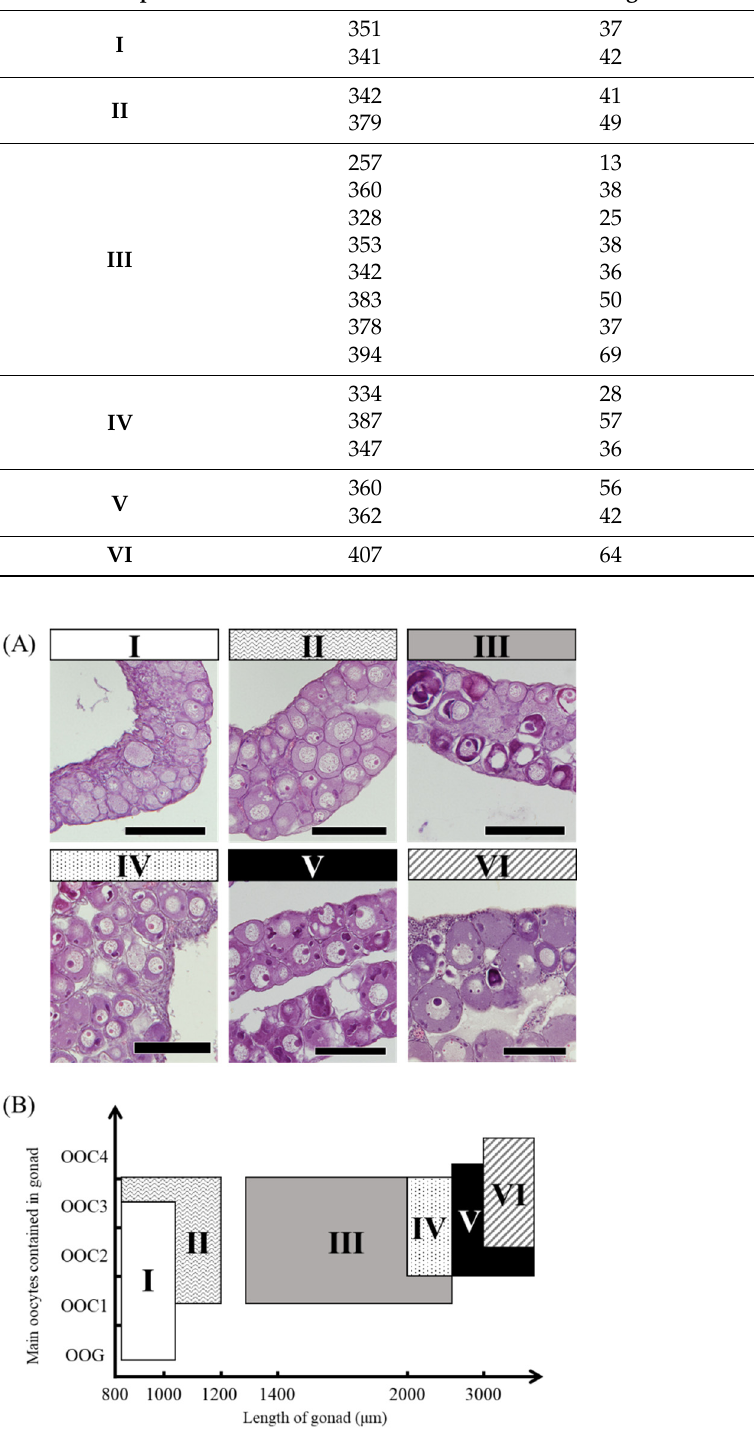
Figure 8. Ovarian developmental stages in the wild Japanese eel Anguilla japonica. ( A ) OOG: oogonial cyst, OOC1: cyst of early meiotic oocytes, OOC2: postpachytene oocyte, OOC3: early previtellogenic oocyte, OOC4: previtellogenic oocyte. Scale bar, 100 µm. ( B ) Distribution of groups Ⅰ – Ⅵ using ovarian developmental stages and the width of gonadal cross-sections.